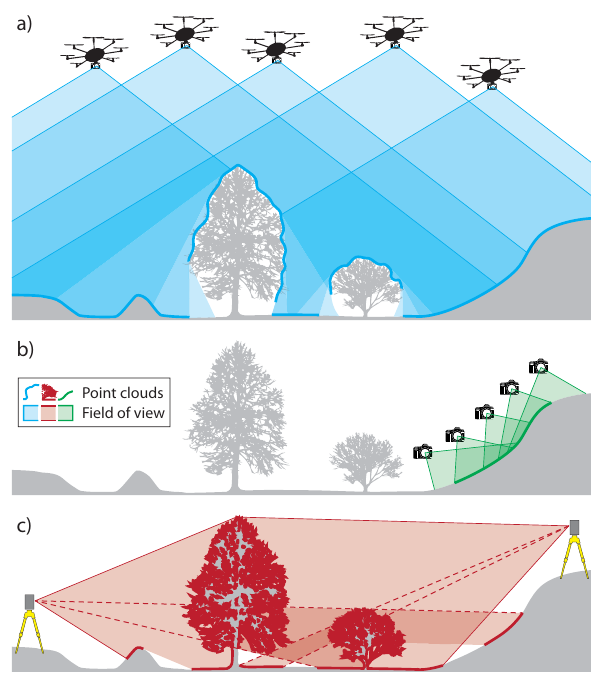
Figure 3. Data acquisition principles of the considered platforms/sensors including UAV (a), TerrPh (b) and TLS (c).